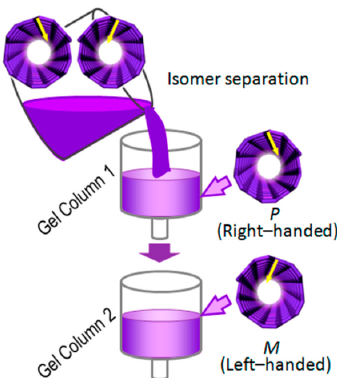
Figure 16. Illustration of the enantioseparation of P - and M -SWCNTs by gel permeation liquid chromatography on an allyl-dextran stationary phase. Reprinted with permission from [69]. Copyright (2014) American Chemical Society.